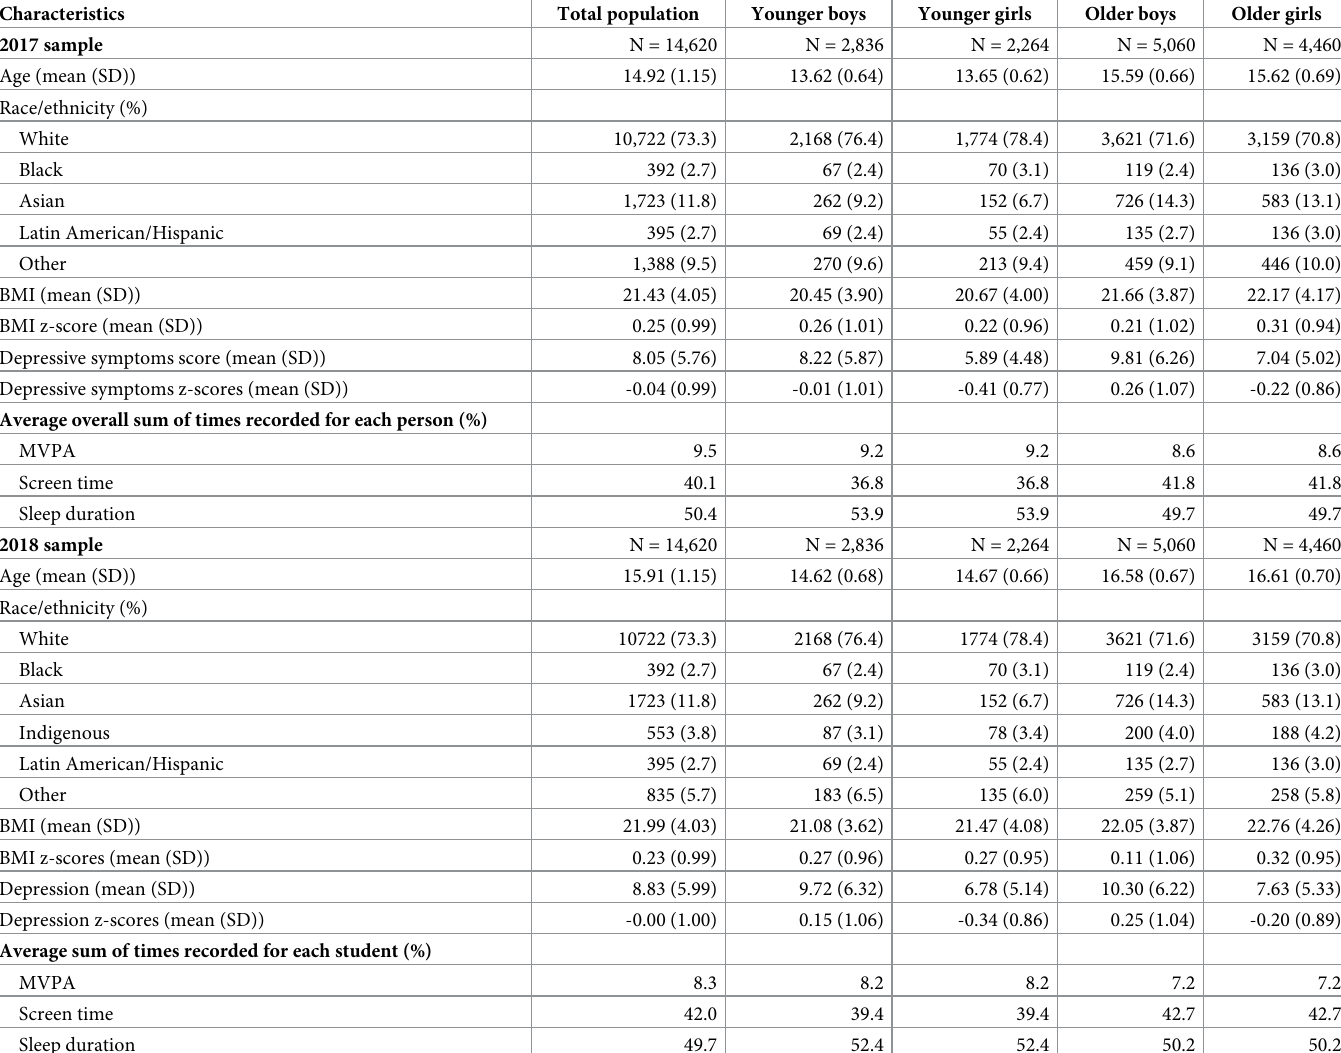
Table 1. Descriptive characteristics of the study